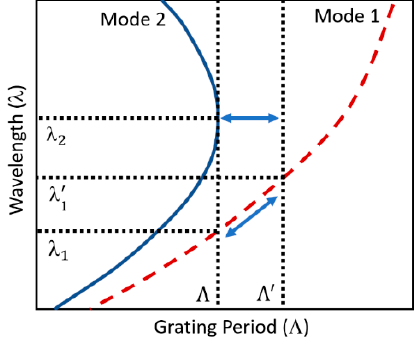
Figure 1. Sketch of the phase-matching curves.